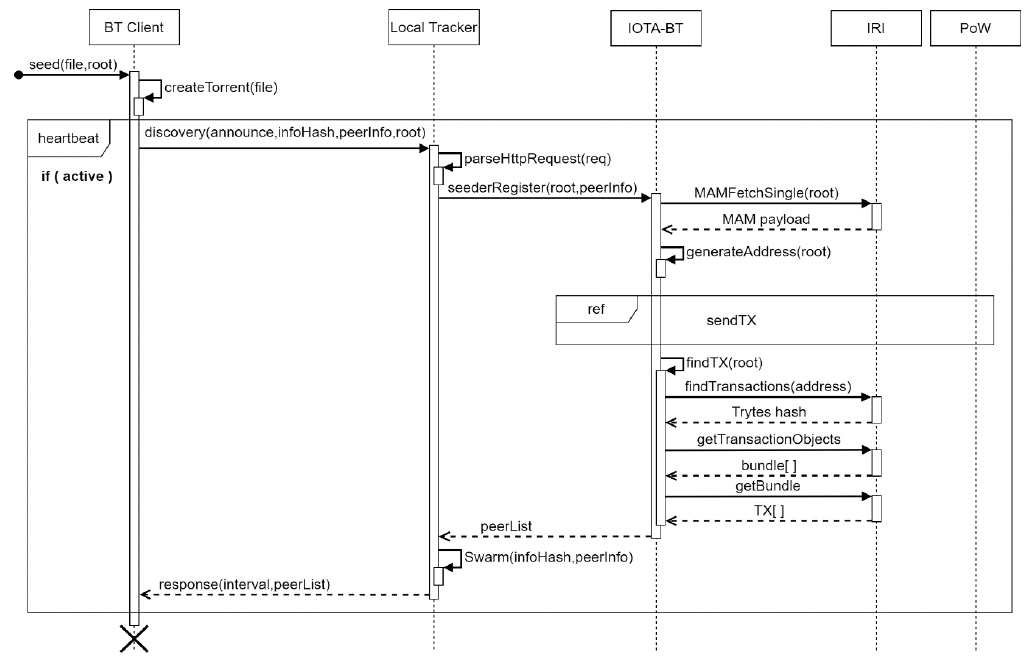
Figure 6. Seeding process in IOTA-BT.